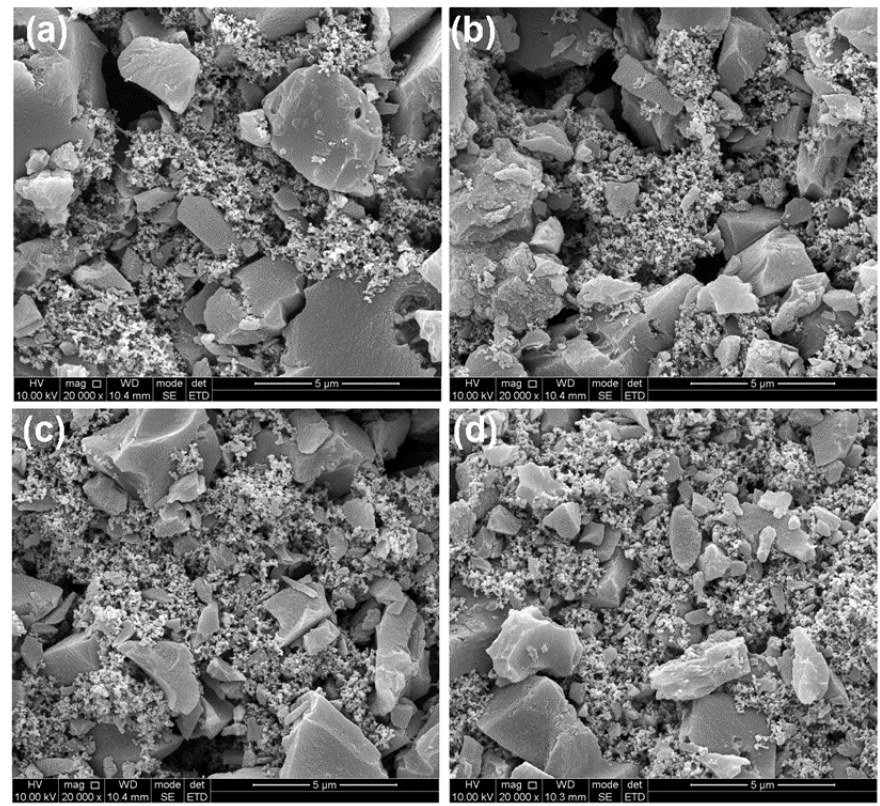
Figure 3. SEM images of Bare AC and ZnO-coated AC at 70 °C: ( a ) Bare AC; ( b ) 2-cycle ZnO; ( c ) 6-cycle ZnO; ( d ) 20-cycle ZnO.